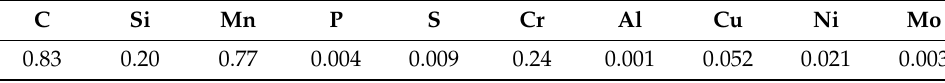
Table 1. Chemical composition of the steel studied, %